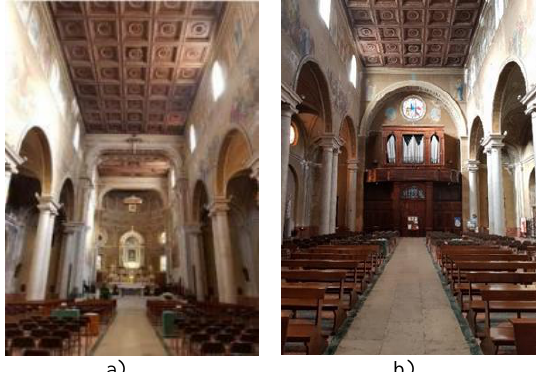
Figure 2. Internal views of the church: a) towards the apse and b) towards the counter façade. The wooden ceiling is visible over the nave Drawings and descriptions mention the presence of masonry groin vaults to cover the two aisles. However,